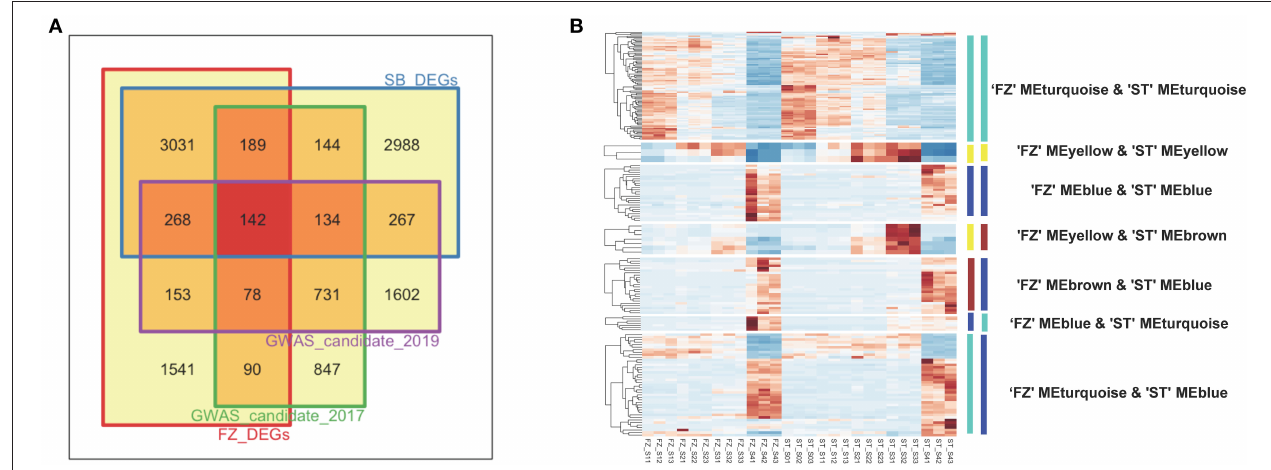
FIGURE 6 | Integration of GWAS analysis with transcriptome sequencing. (A) Venn diagram comparing GWAS-identified candidate genes and differential expression genes (DEGs) detected for cultivar “FZ” and “ST,” (B) Heatmap of 191 candidate genes displaying consistent expression pattern during blooming process in two cultivars. The gene sets were color-labeled corresponding to each module in the network of “FZ” and “ST,”